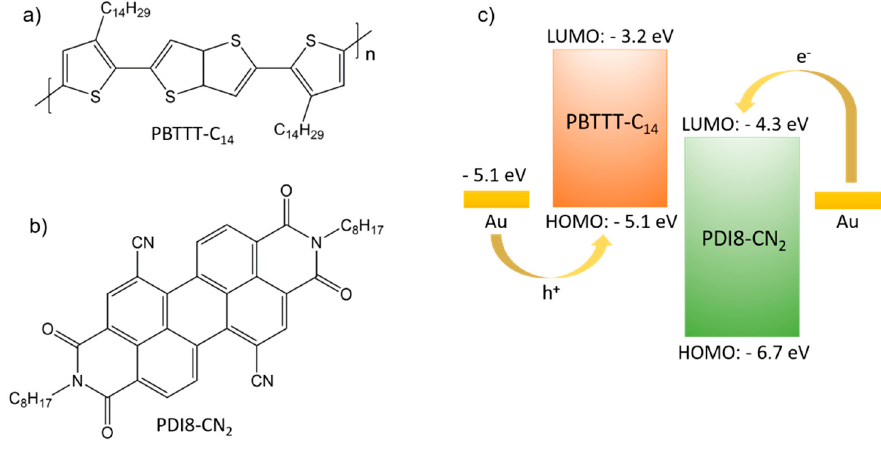
Figure 1. Chemical structures of ( a ) p-type PBTTT-C 14 , ( b ) n-type PDI8-CN 2 and ( c ) an energy level diagram of the bulk heterojunction (BHJ) organic field-effect transistor (OFET).